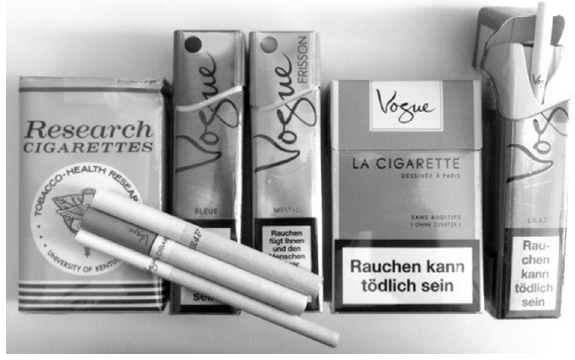
Figure 1. Design of the cigarettes and cigarette packets of the investigated cigarettes. Table 1. Characteristics of KSC 3R4F (reference), KSC Vogue La Cigarette, and three SSL cigarettes (Bleue, Menthe, Lilas). KSC—king size cigarette, SSL—super slim size.